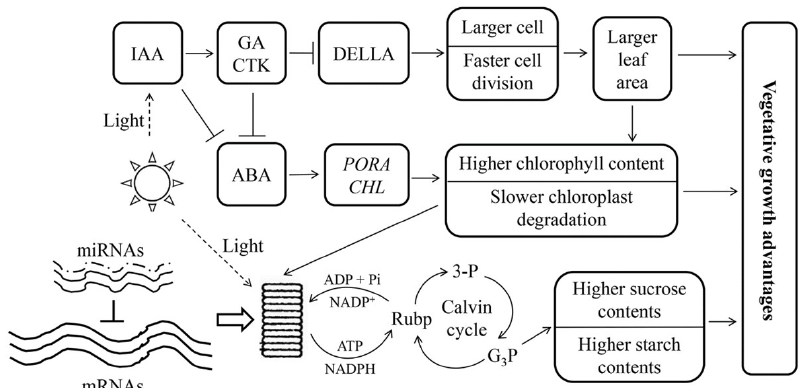
Figure 7 . A model of the vegetative growth advantages of Populus allotriploid . Arrows and short-term indicate promotion and inhibition, respectively. The solid lines of mRNAs represent the dosage effect in Populus allotriploid, and the dashed lines of miRNAs represent no dosage effect in Populus allotriploid. 3-P: triphosphoglycerate; G 3 P: triglyceride